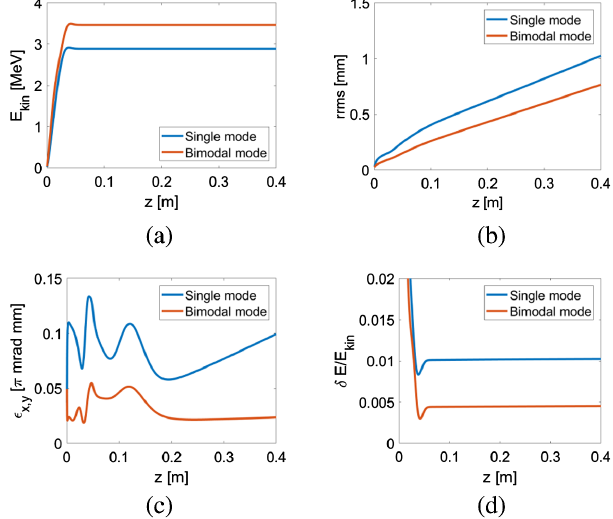
FIG. 6. Emittance compensation solenoid and beam dynamic performance along the z axis. (a) Energy gain evolution (b) Bunch size evolution (c) Transverse emittance evolution (d) RMS Energy spread